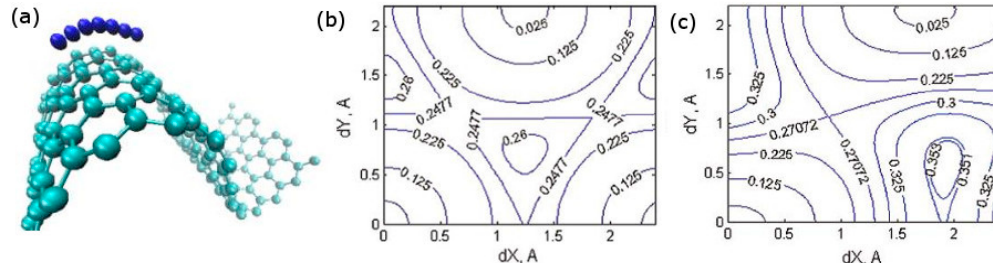
Figure 4. ( a ) An alkali atom’s diffusion path on a curved graphene sheet; ( b , c ) Potential energy surface for Li on planar ( b ) and curved (( c ), contracted to 65% of the original length, adsorption on the convex side) graphene. dX and dY are Cartesian displacements from the hollow adsorption site at the point of maximum curvature. X is the direction of maximum curvature. Reprinted with permission from [18], © (2013) Cambridge University Press.